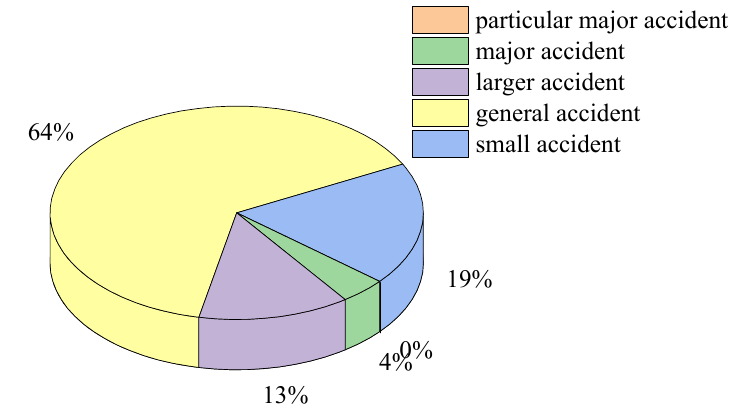
Figure 3. Distribution of accident levels.